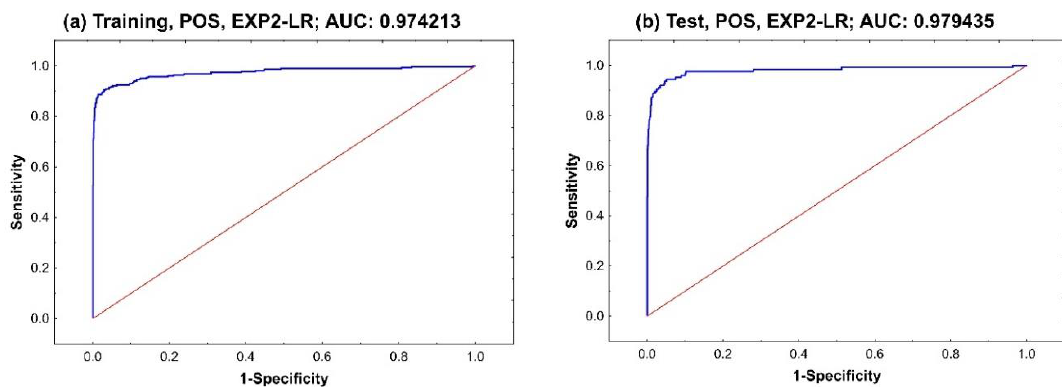
Figure 5. ROC curves and AUC values of EXP2-LR for the POS class label: ( a ) training set and ( b ) test set.